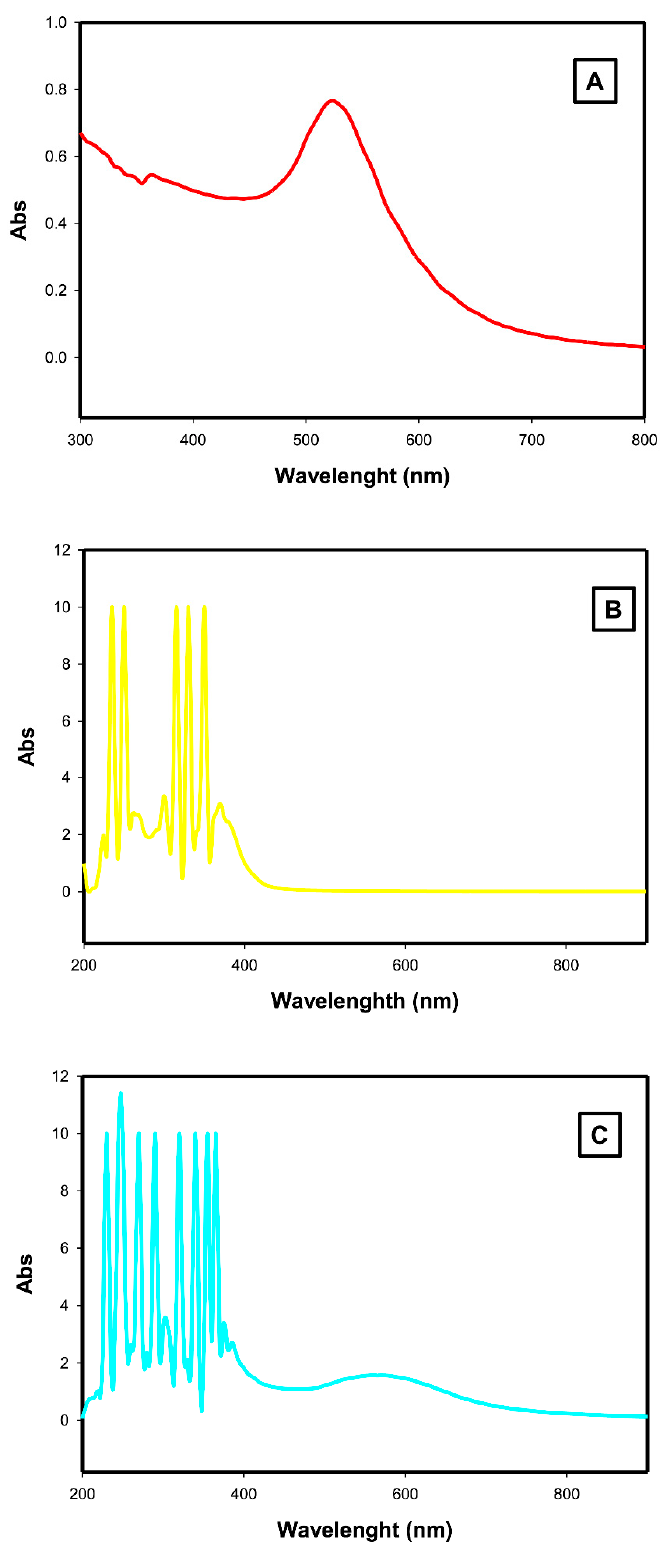
Figure 1. UV-visible spectra of ( A ) AuNPs, ( B ) ALA, and ( C ) AuNPs-ALA mixture.